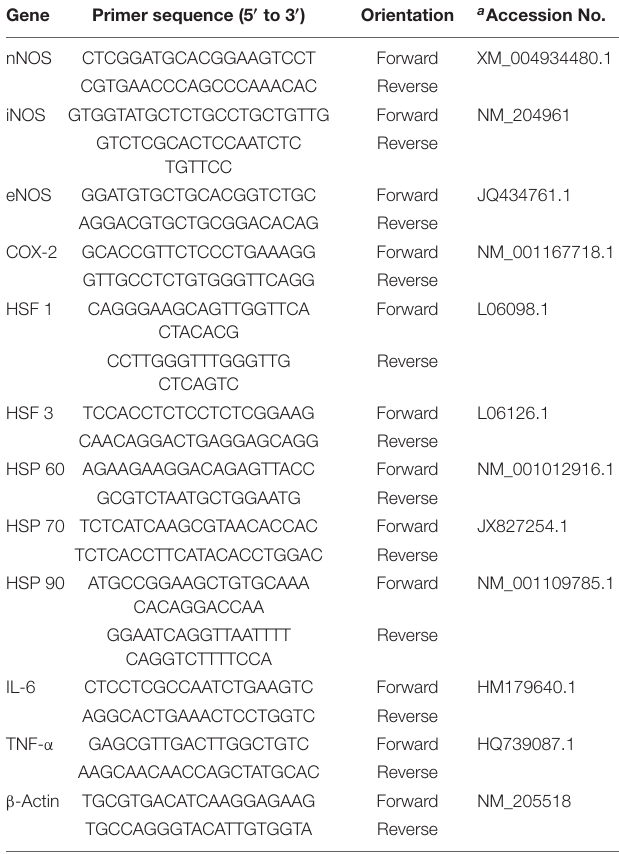
TABLE 2 | List of primers used for real-time PCR analysis.